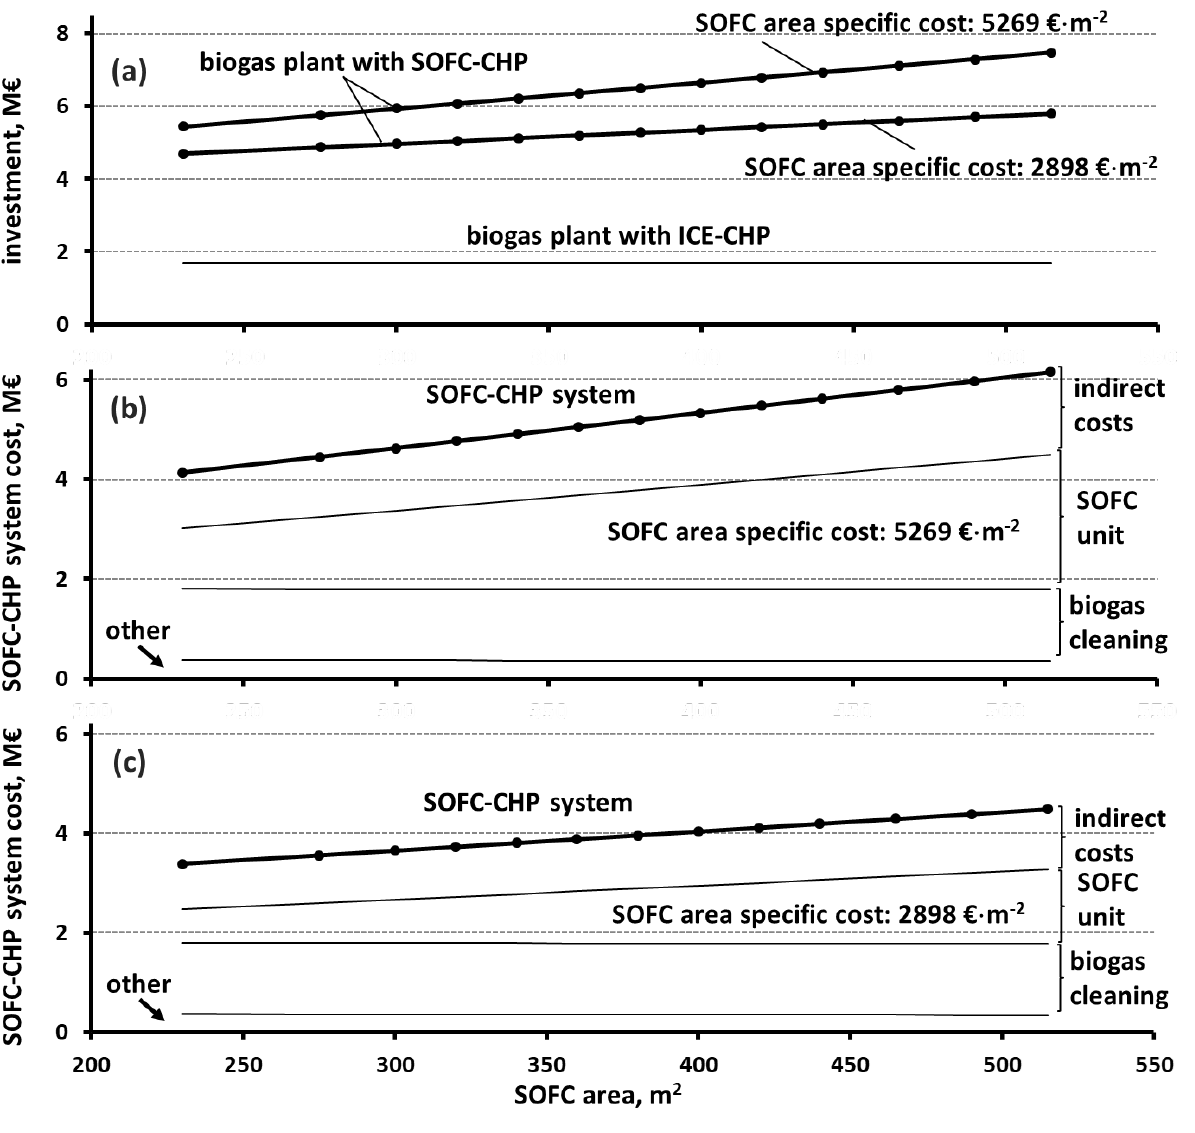
Figure 5. Initial investment of: ( a ) the conventional biogas-CHP plant with ICE-CHP, for 250 m 3 ·h −1 biogas production capacity, and of the corresponding SOFC-CHP system, for ( b ) 2898 EUR·m −2 SOFC area specific cost and ( c ) 5269 EUR·m −2 SOFC area specific cost.